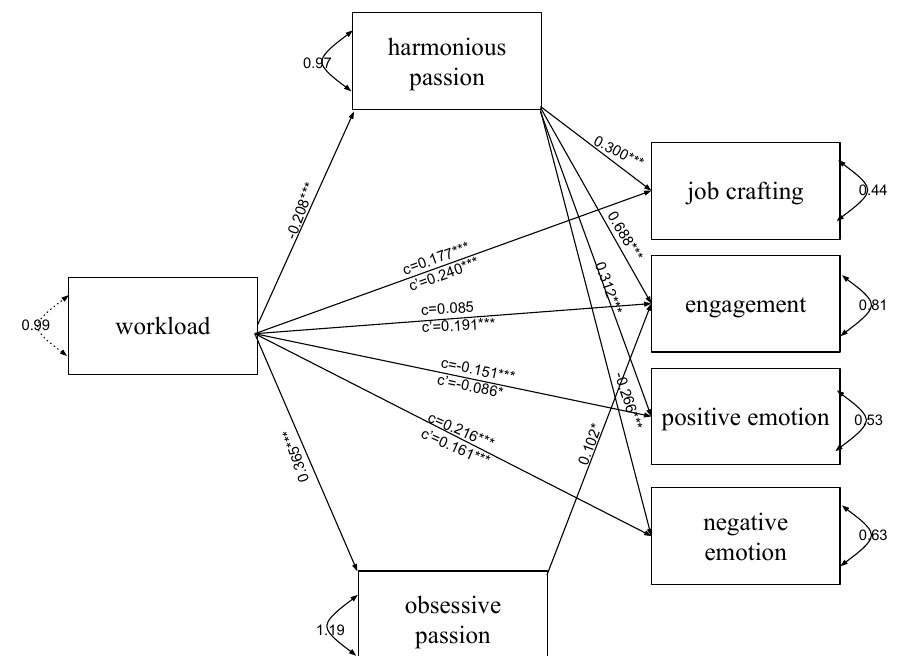
Figure 2. The final model with workload as an independent variable (model 1). The unstandardized path estimates (coefficients) were shown. Note. * p < 0.05; *** p < 0.001.